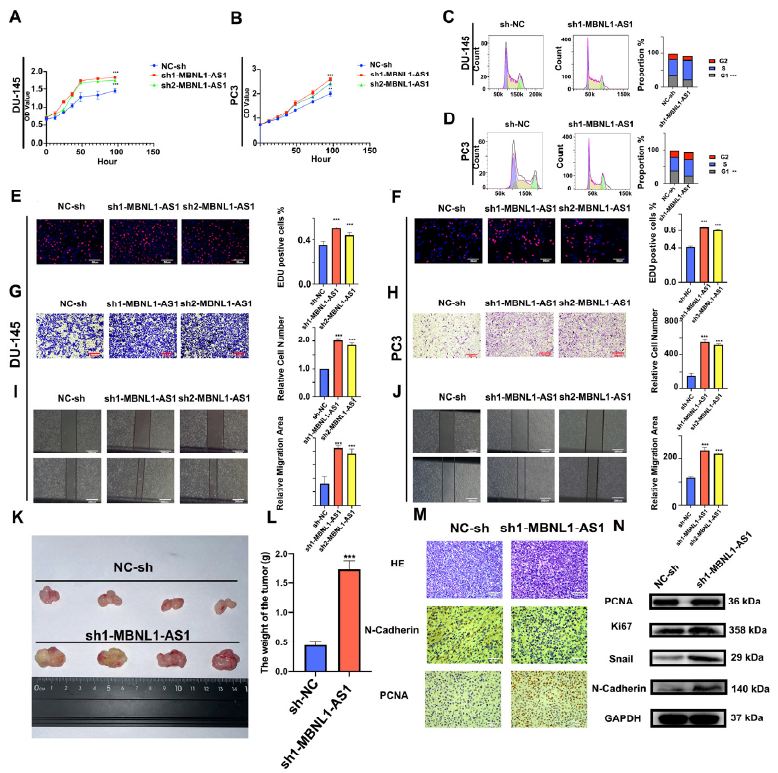
Figure 4. Effects of silencing MBNL1-AS1 expression on the proliferation, cell cycle distribution, and invasion of PC cells. ( A , B ) Cell proliferation was detected using the CCK-8 assay following MBNL1-AS1 knockdown. ( C , D ) Changes in cell cycle distribution were assessed by flow